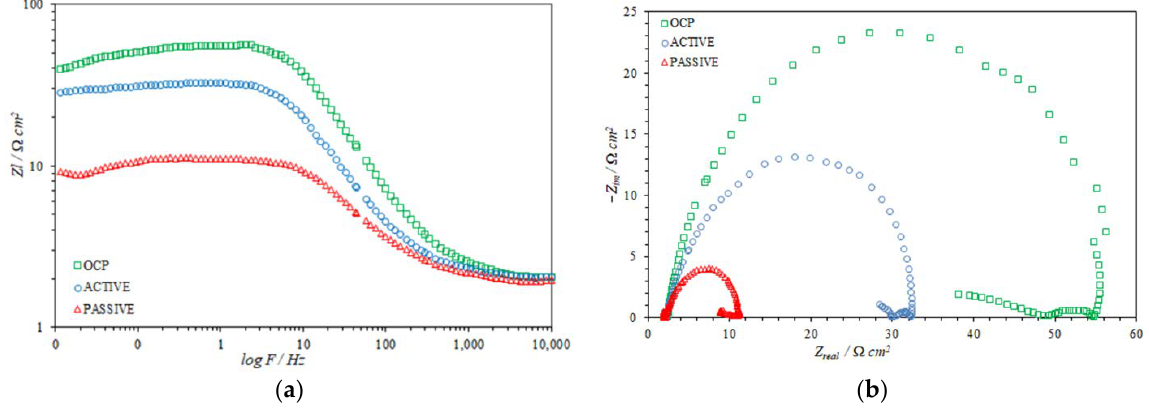
Figure 7. ( a ) Bode impedance plots, ( b ) Nyquist plots conducted at CoNiCrAlY coating samples in 0.5 M sulfuric acid after polarization of 100 mV (active) and 500 mV (passive).